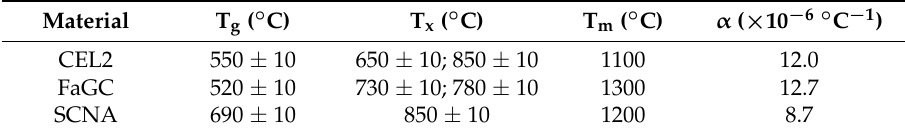
Table 3. Results of the thermal analyses carried out for the starting materials.